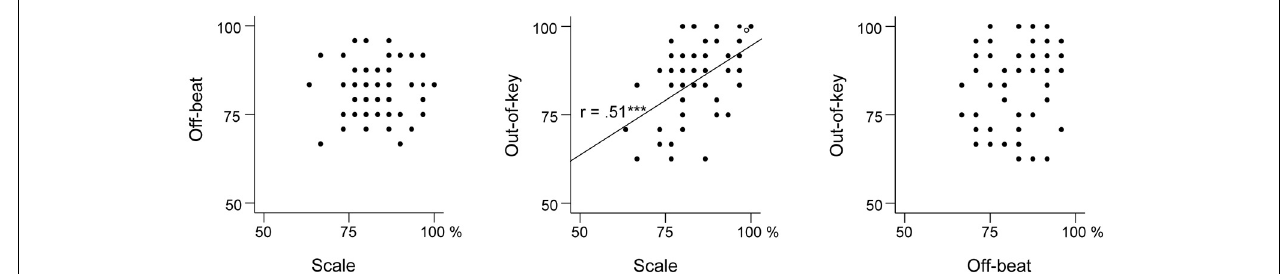
FIGURE 5 | Scatter plots indicating the relationships between the three music perception subtests.